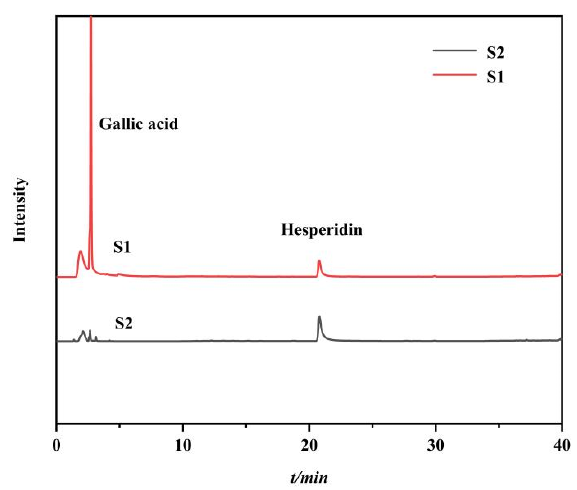
Figure 7. HPLC diagrams of model mixture ( S1 ) and methanol eluent of the ligand fishing by Fe 3 O 4 -COOH@UiO-66-NH 2 @PPL ( S2 ).